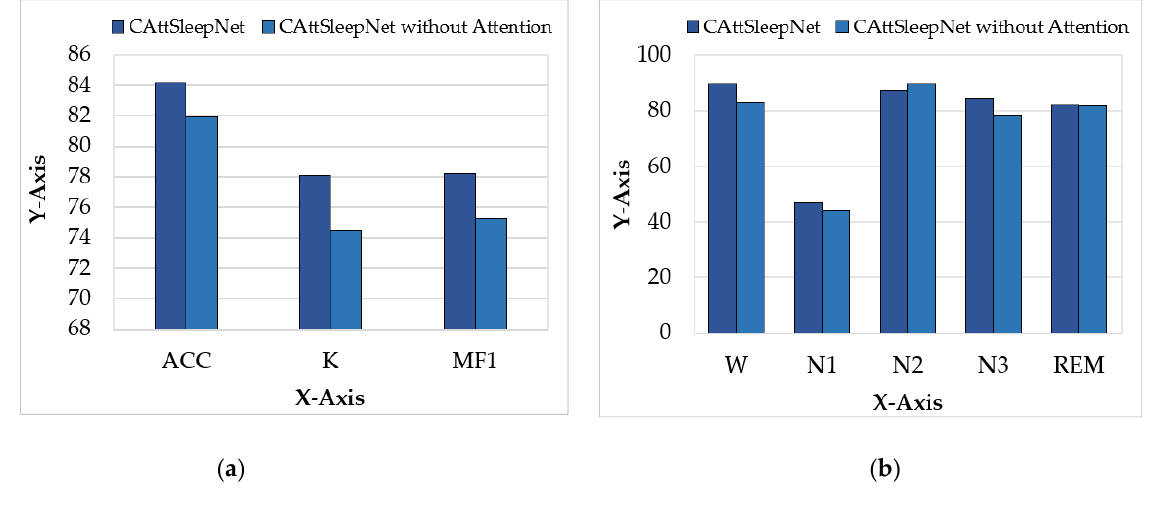
Figure 8. Visual comparison of the two models. ( a ) Comparison of overall indicators; ( b ) comparison of per-class F1-score. Table 5. Ablation experiments on Fpz-CZ channel of the sleep-edfx-2013 dataset.